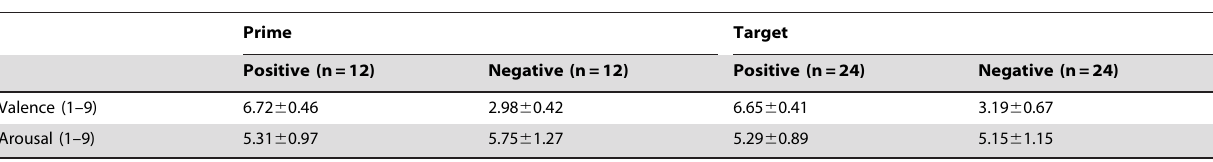
Table 1. Emotional ratings ( M 6 SD ) for primes and targets.